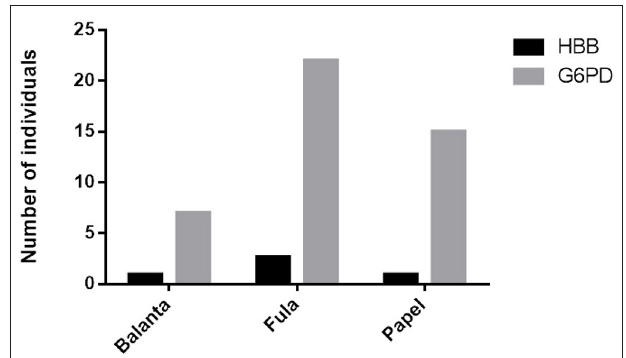
FIGURE 1 | Distribution of the HbS allele (HBB mutation) and the G6PD mutation in the three main ethnic groups: Balanta, Fula, and Papel.